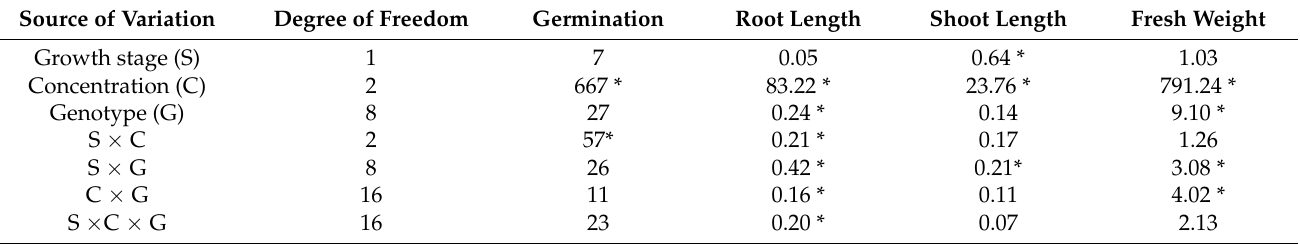
Table 2. Analysis of variance (mean squares) for traits in tested growth stages (butonisation